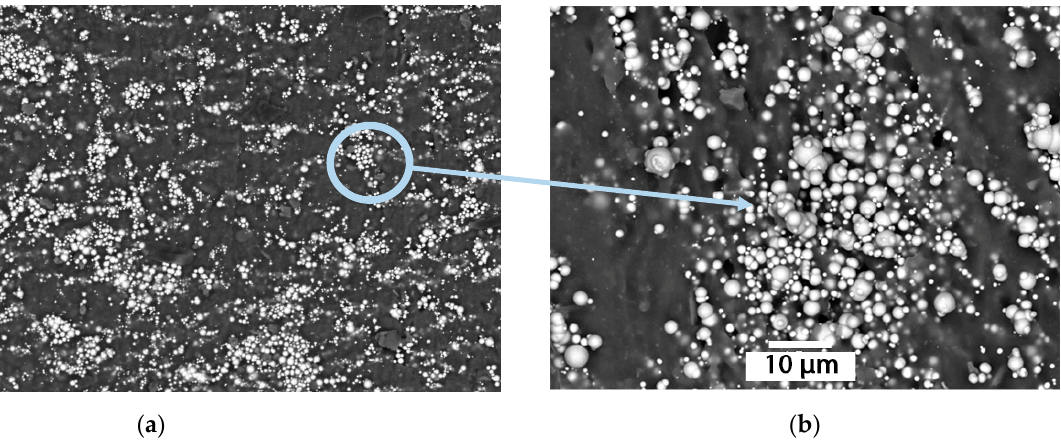
Figure 6. Agglomeration areas formation in course of MAE polymerization with R-10 filler in an external magnetic field, 70%: ( a ) increase up to 50 µm; ( b ) increase up to 10 µm.